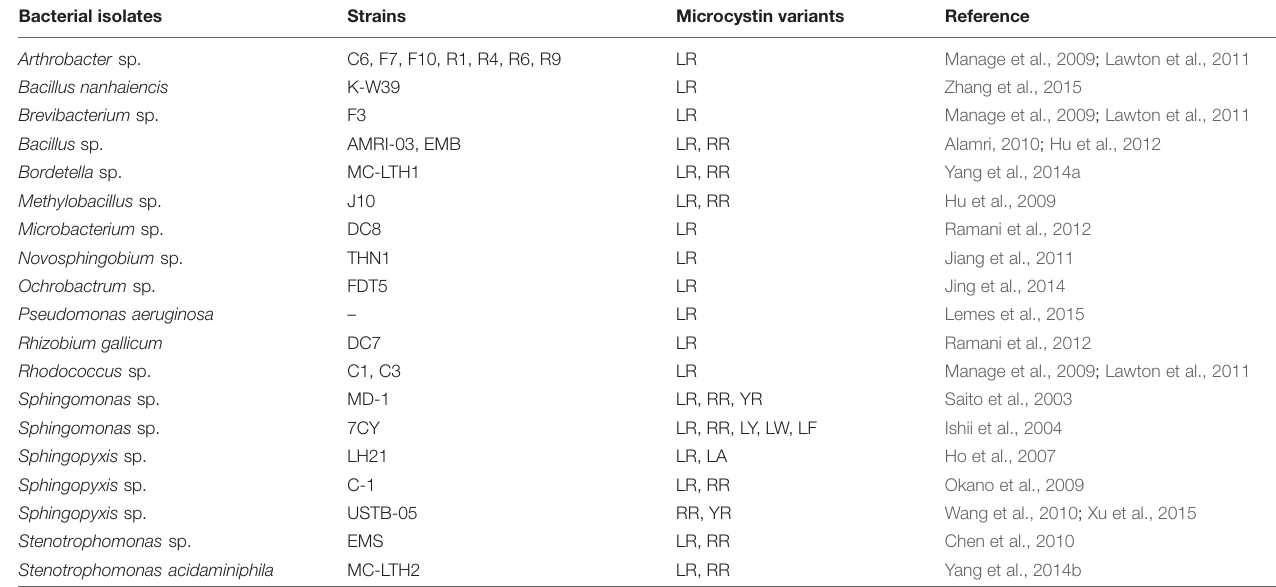
TABLE 3 | Biological control of some common cyanotoxins by different bacterial isolates. Bacterial